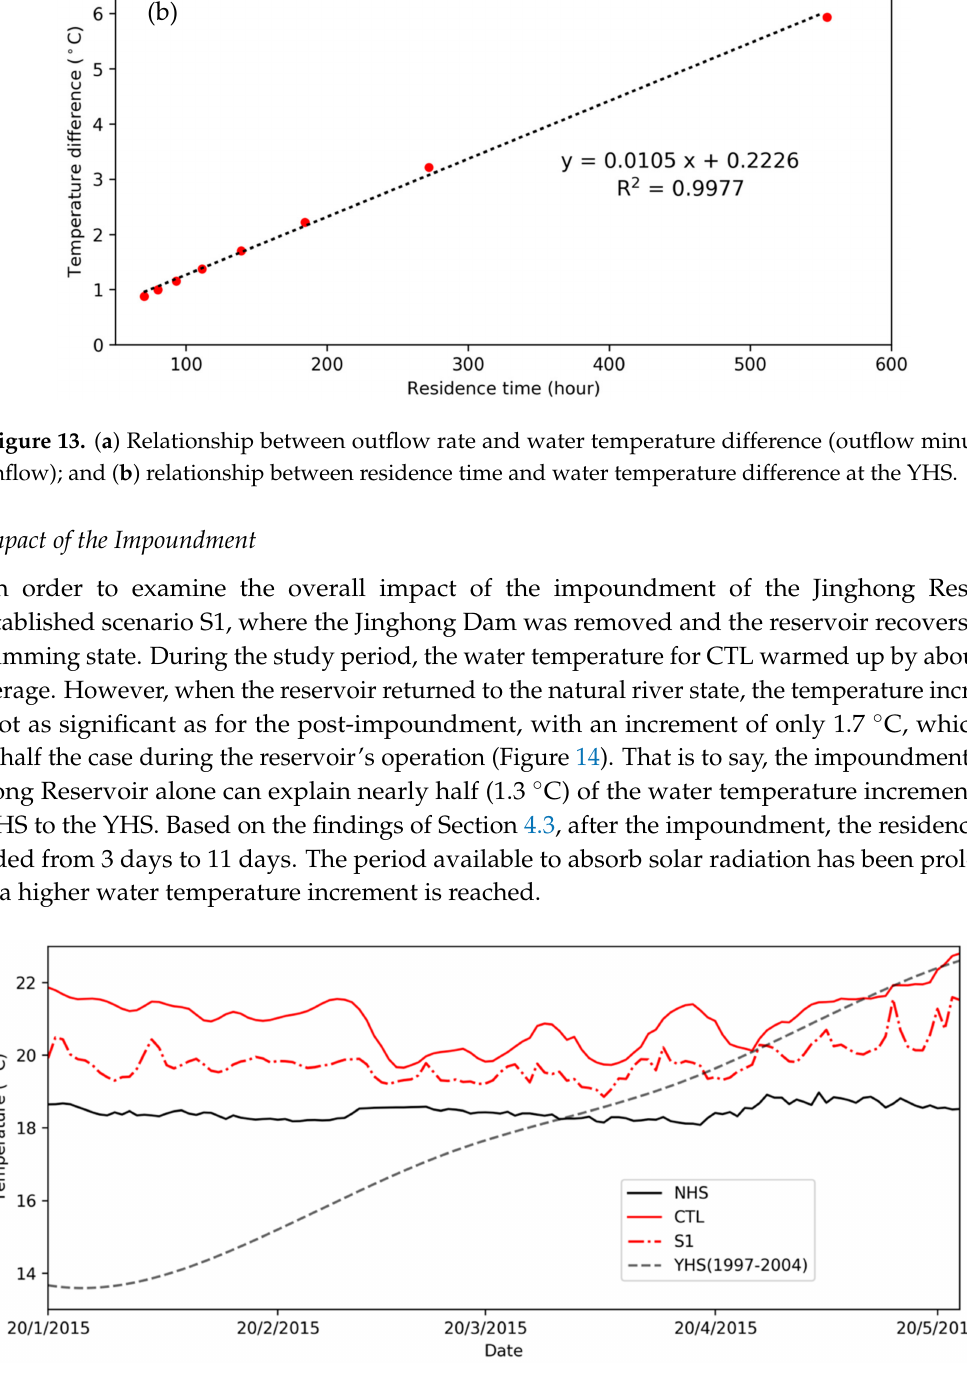
Figure 14. Simulated water temperature during the study period by CTL and S1 at the YHS, and measured water temperature at the NHS and historical water temperature (1997–2004) at the